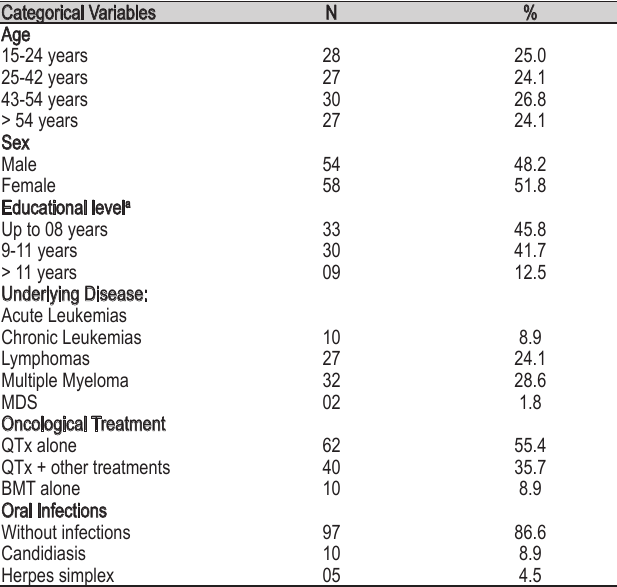
Table 1 - Sociodemographic characteristics of the base disease of the oncological treatment instituted, and the oral infections in onco-hematologic individuals at HUPES/UFBA, Salvador, Brazil,